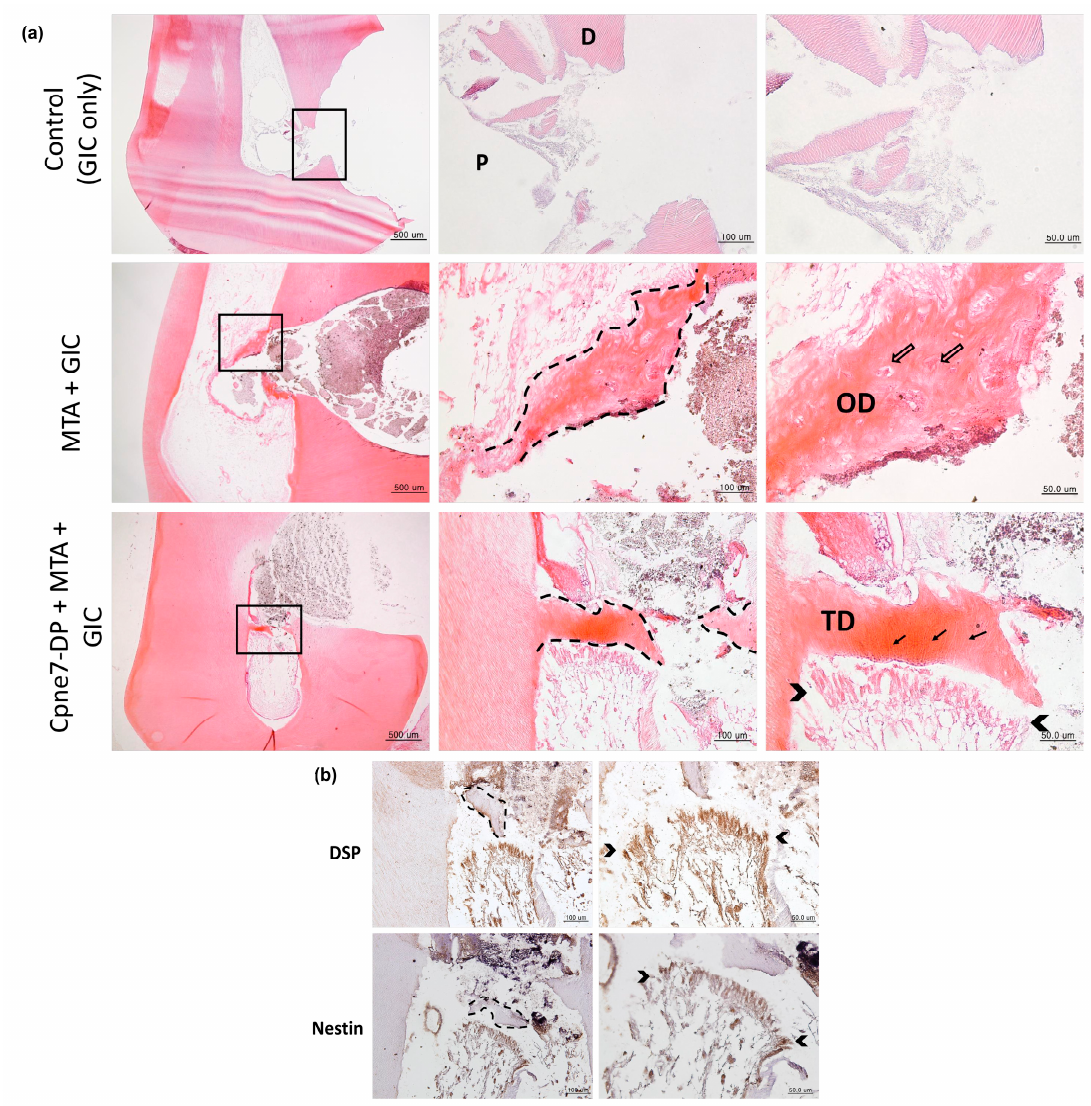
Figure 5. Cpne7-DP treatment induces the regeneration of tubular orthodentin in pulp exposure canine models. ( a ) Histological analysis of dental pulp responses at the complete pulp exposure areas filled with glass ionomer (GI) cement only, or sealed with MTA before GI cement filling, or sealed with MTA dissolved in Cpne7-DP before GI cement filling. Samples were analyzed by hematoxylin and eosin staining after 12 weeks ( n = 6). ( b ) Immunohistochemical staining of cells underlying the newly formed dentin bridge in (A) with anti DSP (1:100) and anti-Nestin (1:100) in the pulp exposure model treated with Cpne7-DP. Empty arrows indicate the lacunae containing osteocytes; arrows indicate the dentinal tubules. Dashed line indicates the newly formed dentin bridge edge. Brackets outline the newly di ff erentiated odontoblast layer. P, pulp; D, dentin; TD, newly formed tertiary dentin; OD,